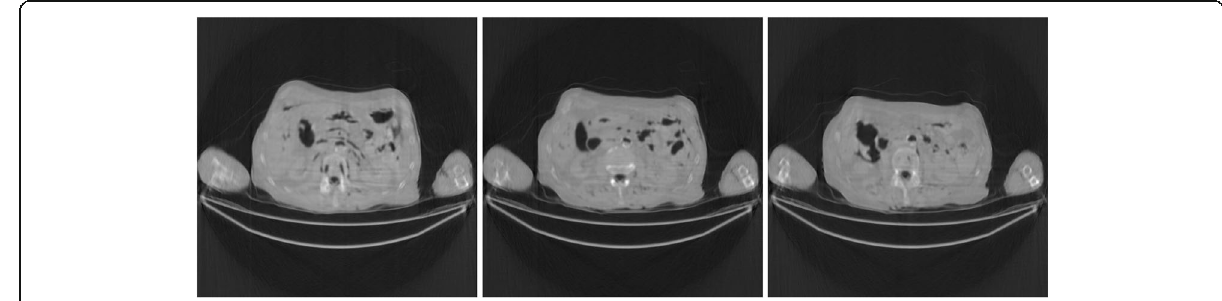
Fig. 4 FBP reconstruction of three image slices using a nonstationary Gaussian pre-filter h whose σ h is defined in Eq. (5) with a = 2.5, b = 2, and c = − 2.49975. Left to Right: Slice 1, Slice 32, and Slice